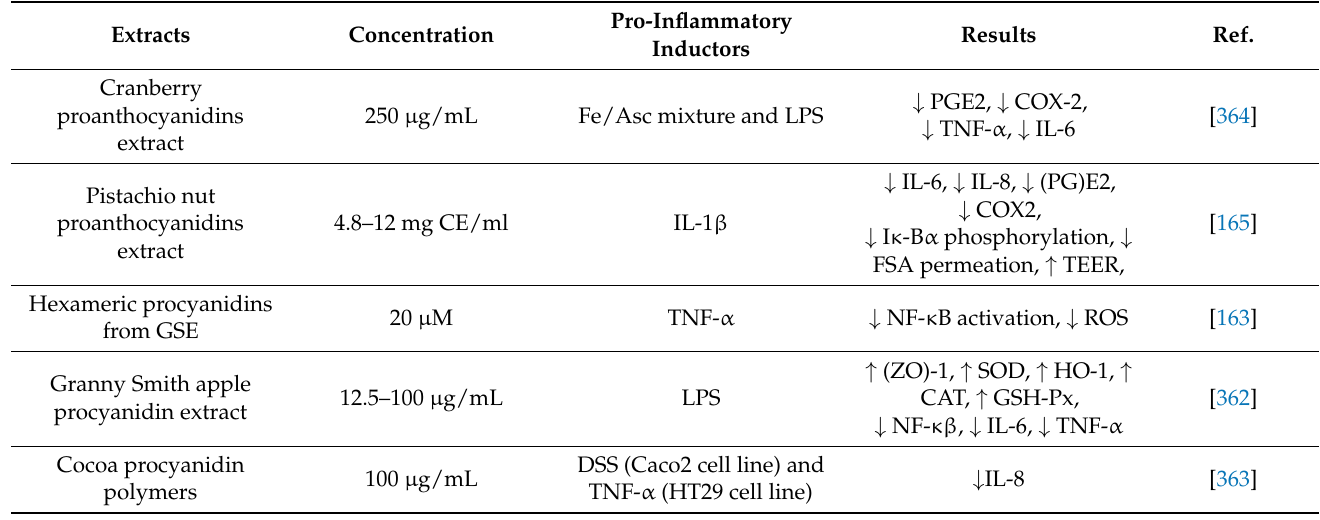
Table 4. In vitro studies reporting the anti-inflammatory activity of PACs.